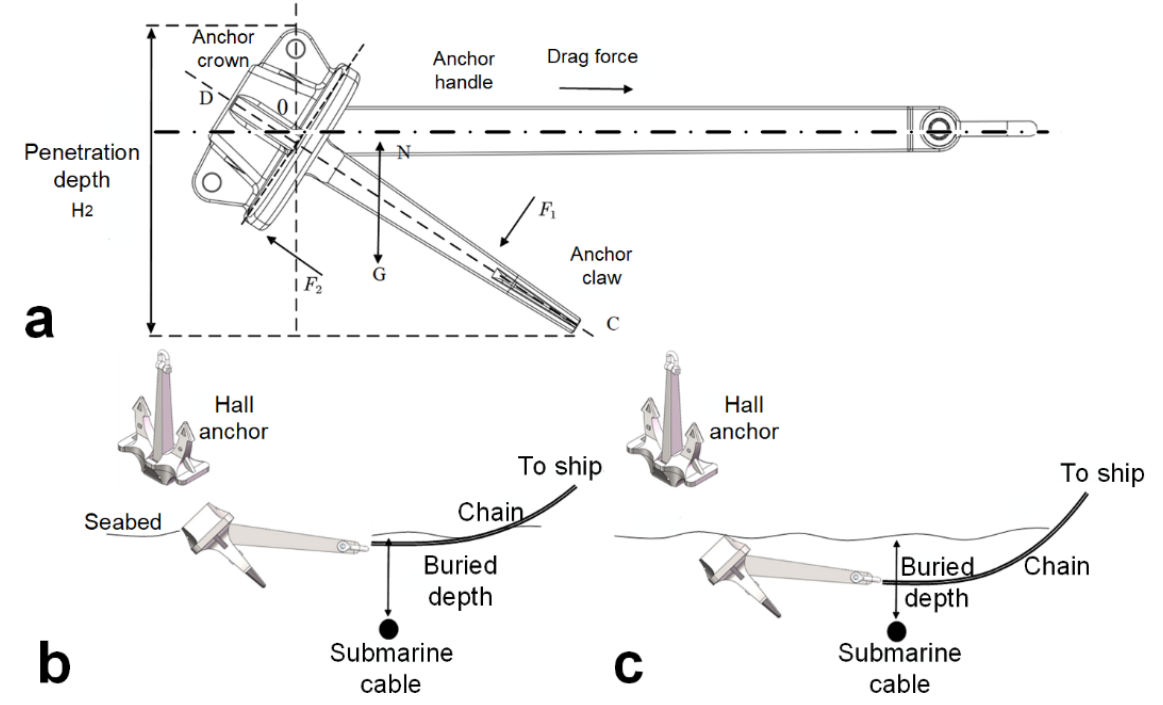
Figure 4. The drag force of the anchor in different states. ( a ) Force analysis of anchor dragging, ( b ) the anchor claw is submerged in the soil, and ( c ) the anchor crown is submerged in the soil.